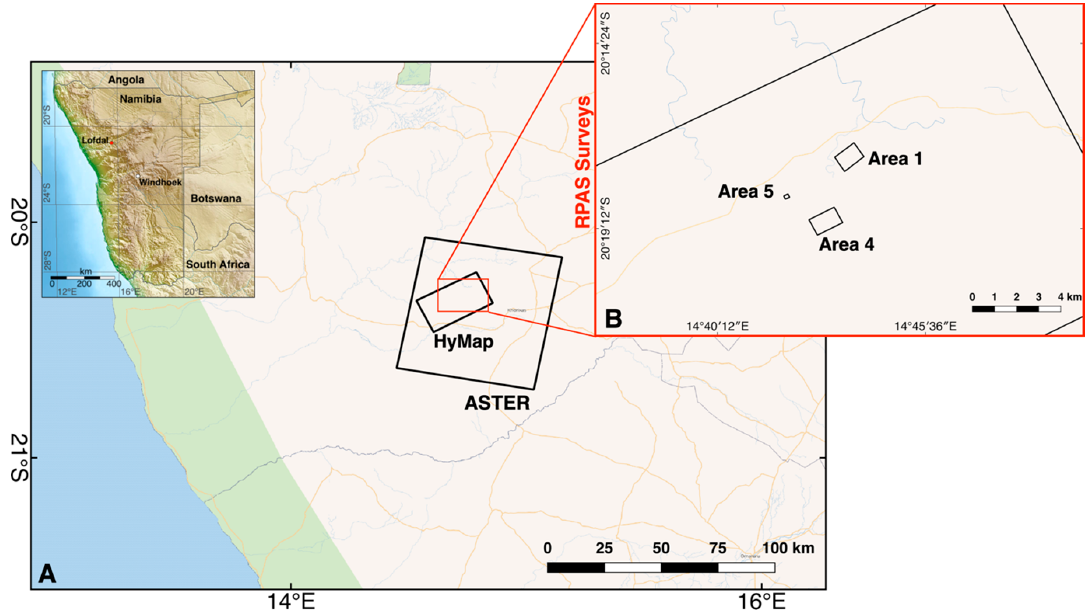
Figure 6. Geographic map showing the spatial extent covered by each data set including an inset of a topographic map of Namibia depicting the location of the Lofdal area. ( A ) Spatial footprints of ASTER and HyMap data. ( B ) Spatial foot prints of the areas covered with RPAS-based surveys.